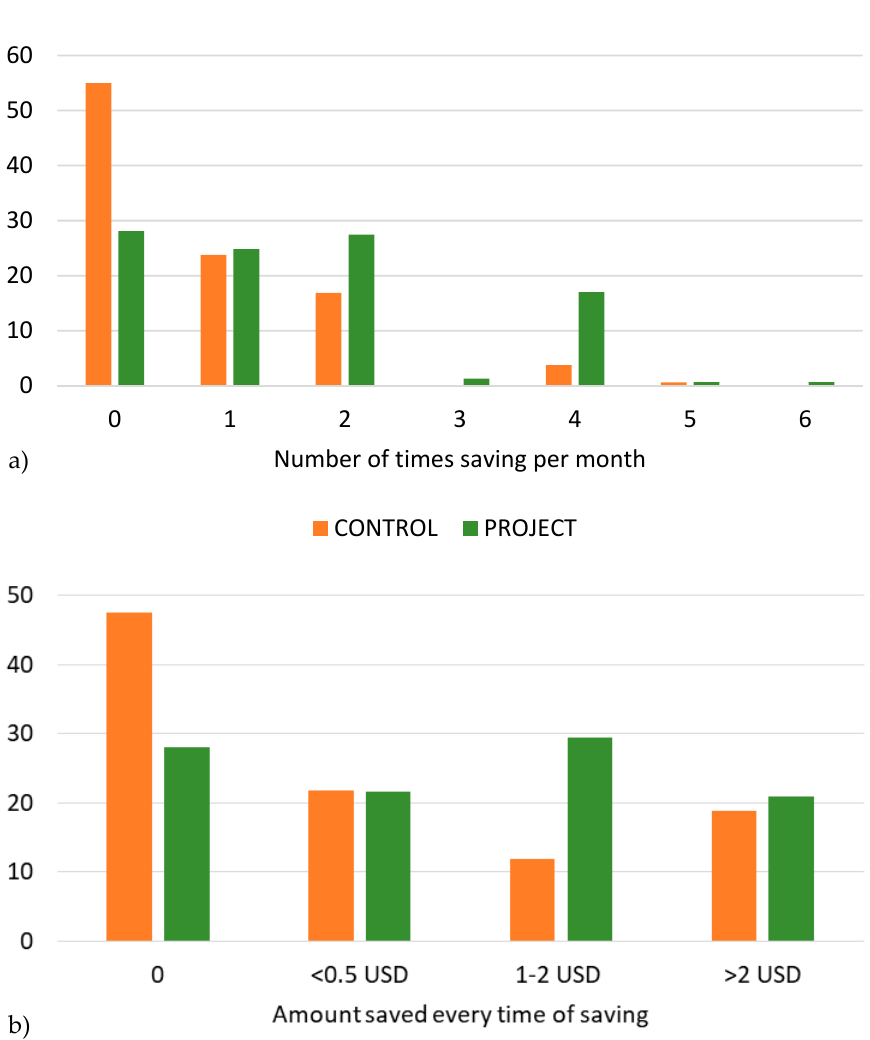
Figure 7. ( a ) Percentage ( y -axis) of project and control farm households saving money on different numbers of occasions per month in 2012. ( b ) Percentage of project and control farm households saving different amounts on every saving occasion in 2012.